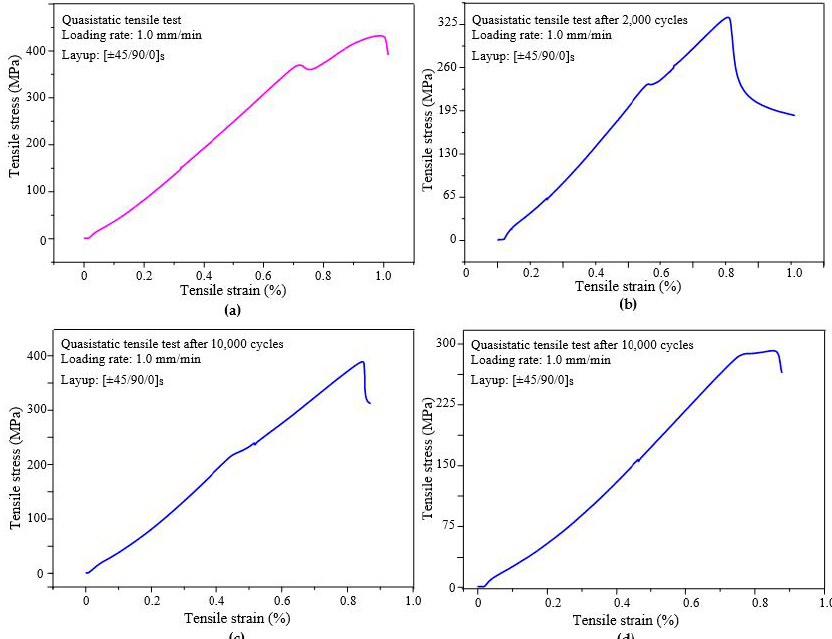
Figure 4. Typical quasistatic stress–strain diagrams of the composite specimens. ( a ) Before fatigue test, ( b ) after 2000-cycle fatigue loading, ( c ) after 10,000-cycle fatigue loading (In this specific case, the ultimate residual tensile strength after 10,000-cycle fatigue loading is higher than that after 2000-cycle fatigue loading due to the scattering behavior of the ultimate tensile strength), and ( d ) after 10,000-cycle fatigue loading.